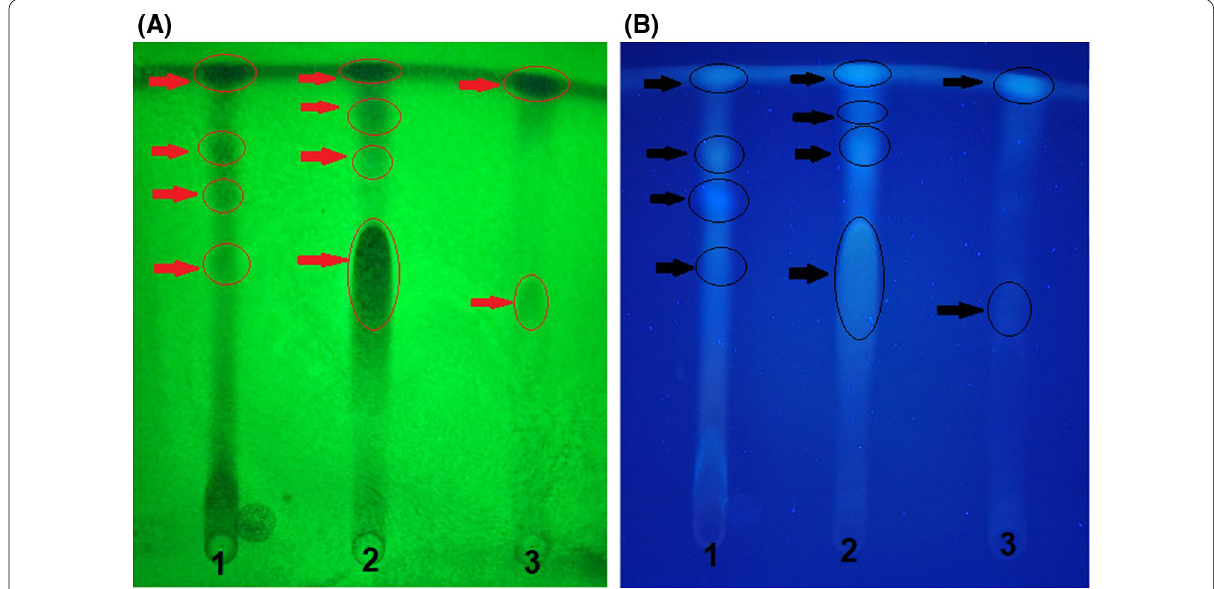
Fig. 4 TLC chromatograms of the methylene chloride extract of A. sydowii AUMC14506 (Lane 1) , A. flavus AUMC14507 (Lane 2) , and L. theobromae AUMC14508 (Lane 3) under UV‑light 254 nm (A) and UV‑light 365 nm (B)